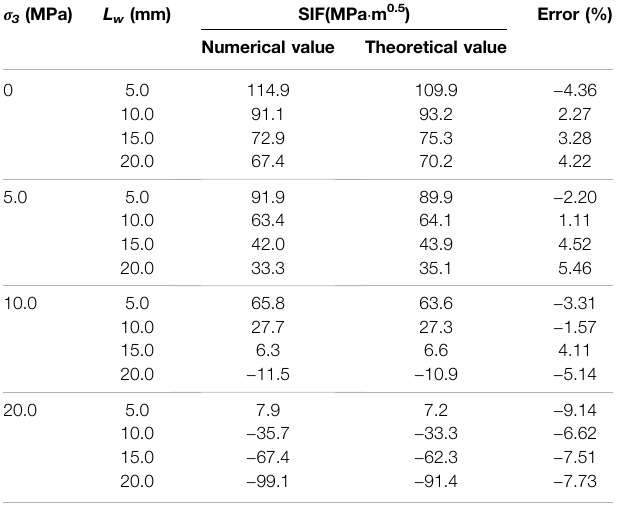
TABLE 2 | Numerical simulation and theoretical calculation results of SIF.